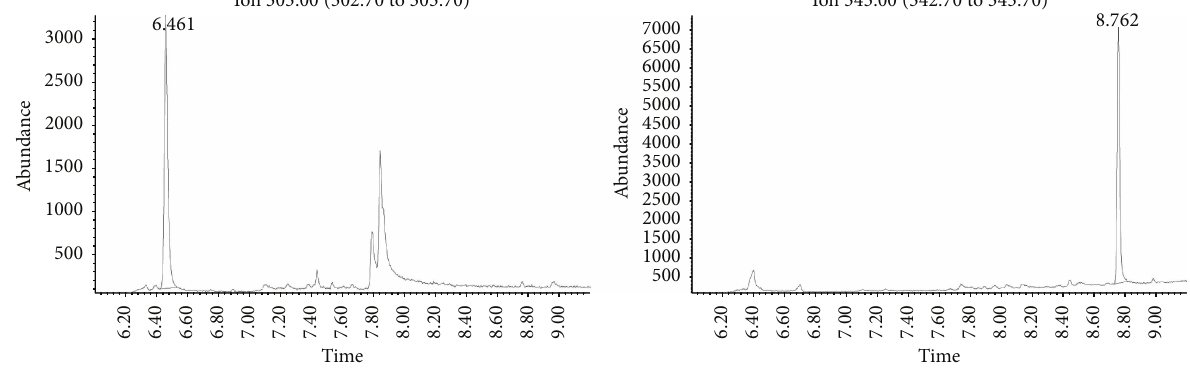
Figure 4: SIM mode chromatogram showing methadone-d9 ( 𝑚/𝑧 : 303) and clotiapine ( 𝑚/𝑧 : 343) in blood